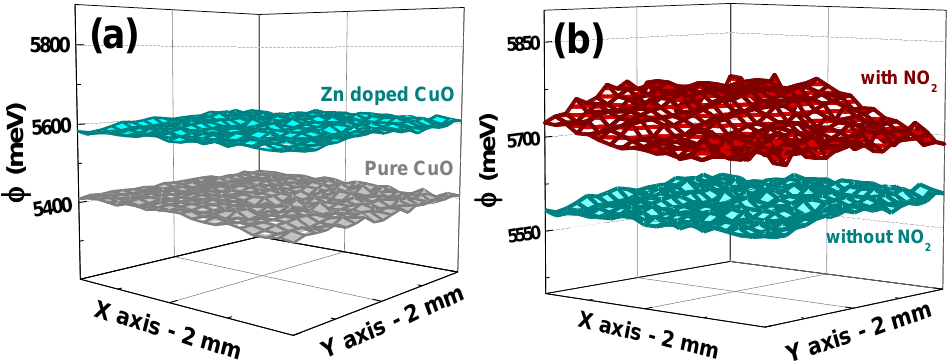
Figure 14. Work function area map (2 mm × 2 mm) recorded for both ( a ) samples P and S6 and ( b ) the change in the work function of sample S6 upon exposure to 50 ppm NO 2